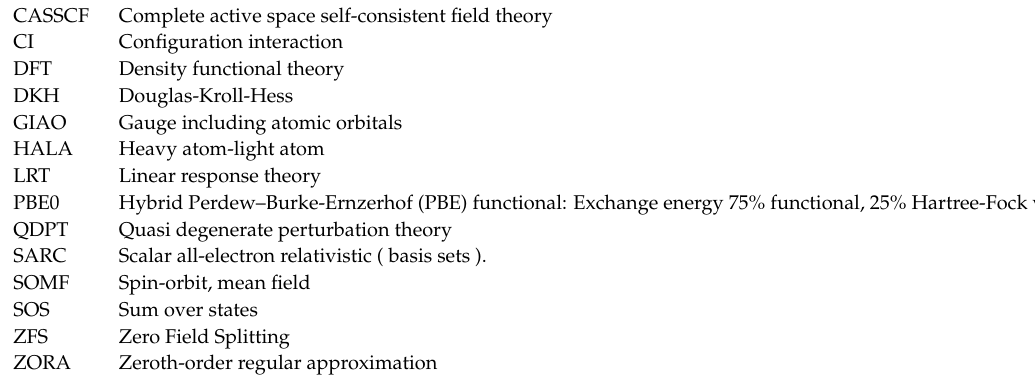
Supplementary Materials: Calculated EPR data for the six molecules (Zeeman, ZFS and hyperfine parameters) is available online at http://www.mdpi.com/2312-7481/5/1/3/s1, Table S1: EPR data for [Nd LPy]3+. Atom numbering of protons refers to Figure 1 of the main text. Hyperfine values averaged over chemically equivalent atoms, Table S2: EPR data for tris(2,6-bis(5,6-dialkyl-1,2,4-triazin-3-yl)pyridine) uranium(III), U(MeBTP)3+. Atom numbering of protons refers to Figure 3 of the main text. Hyperfine values averaged over chemically equivalent atoms, Table S3: EPR data for tris(pentamethylcyclopentadienyl) uranium (III), U(C5Me5)3. Hyperfine values averaged over chemically equivalent atoms, Table S4: EPR data for U(N(SiMetBu2)2)3. Hyperfine values averaged over chemically equivalent atoms, Table S5: EPR data for Tris(trimethylsilyltetramethylcyclopentadienyl)uranium(lll), U(C5Me4SiMe3)3. Hyperfine values averaged over chemically equivalent atoms, Table S6: EPR data for U( η -C5Me4Et)( η -(1,4-C8H6(SiiPr3)2). Hyperfine values averaged over chemically equivalent